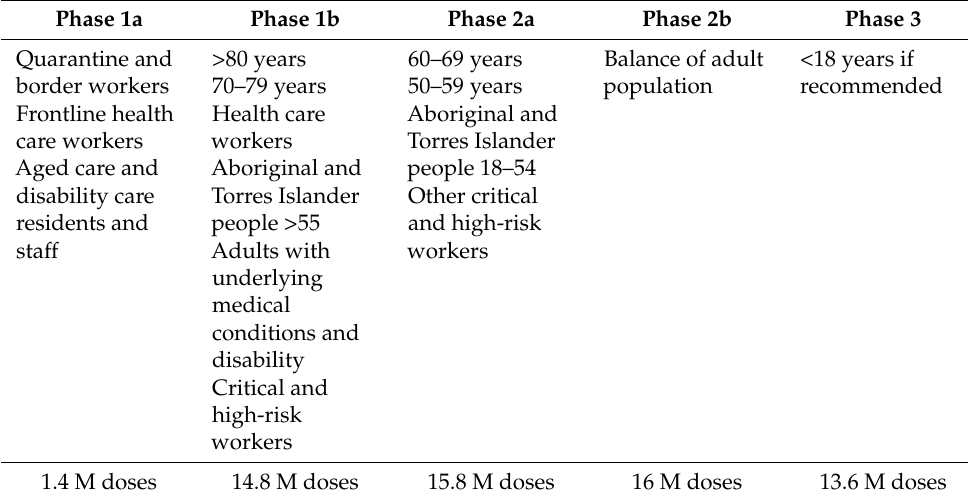
Table 2. Phases of the Australian vaccine national rollout. Based on the publicly available Australian COVID-19 vaccine national roll-out strategy